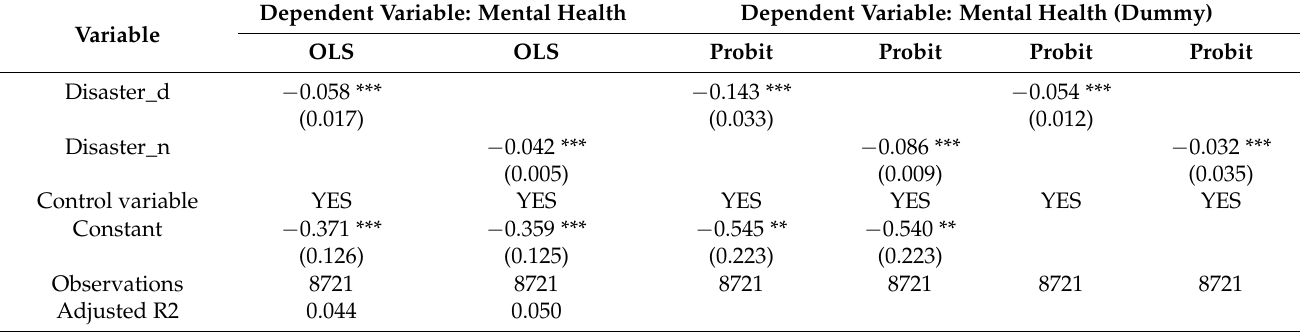
Table 6. Robustness test